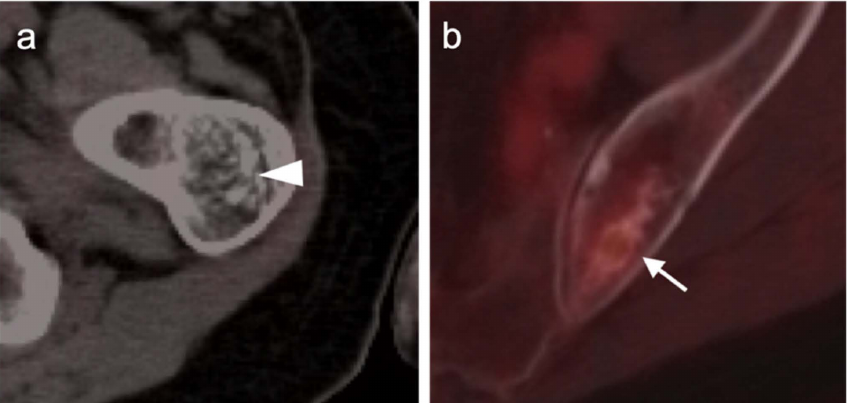
Figure 32. Variable appearance of benign enchondromas on FDG PET-CT. ( a ) A magnified view of an axial FDG PET-CT image of the left proximal femur demonstrates a non-metabolically active, centrally calcified left intertrochanteric lesion (white arrowhead). ( b ) A magnified view of an axial FDG PET-CT image of the pelvis shows mild metabolic activity in a centrally calcified lesion of the medial left iliac bone (white arrow). Both were unchanged over many years and asymptomatic. The development of pain referable to what appears to be a benign enchondroma should prompt evaluation for conversion to possible low-grade chondrosarcoma. Some benign enchondromas can show mild metabolic activity on FDG